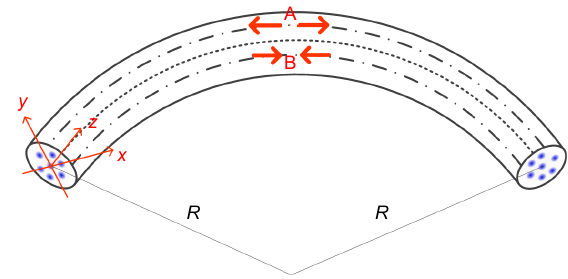
Fig. 2 | Schematic diagram of the bent MCF with a bending radius of R . Core A and Core B represent the elongated outer side core and the compressed inner side core, respectively. Figure reproduced from ref. 24 , Optical Society of